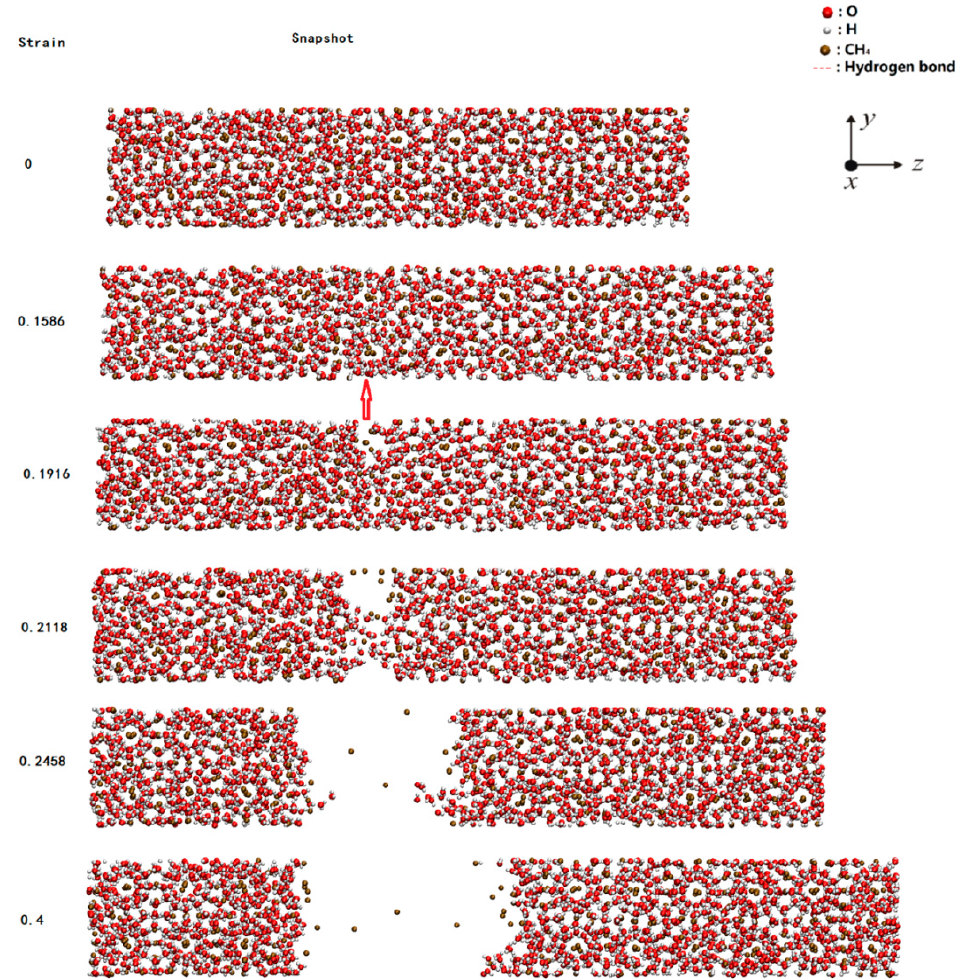
Figure 1. Snapshots of 2 × 2 × 10 (deletion percentage of 5.92%) system during stretching. (The arrow is the place where hydrate cracked).